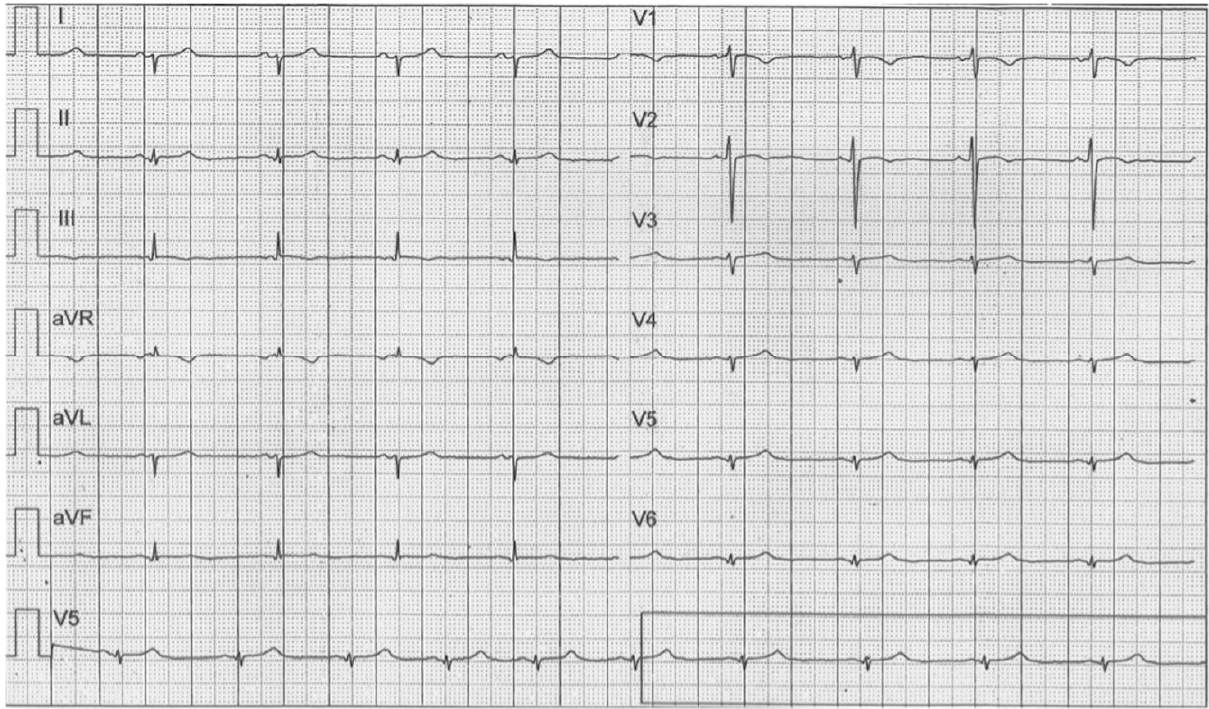
Figure 7. Resting ECG of 29-year-old female swimming teacher, showing right axis deviation of QRS and diffuse low voltages.